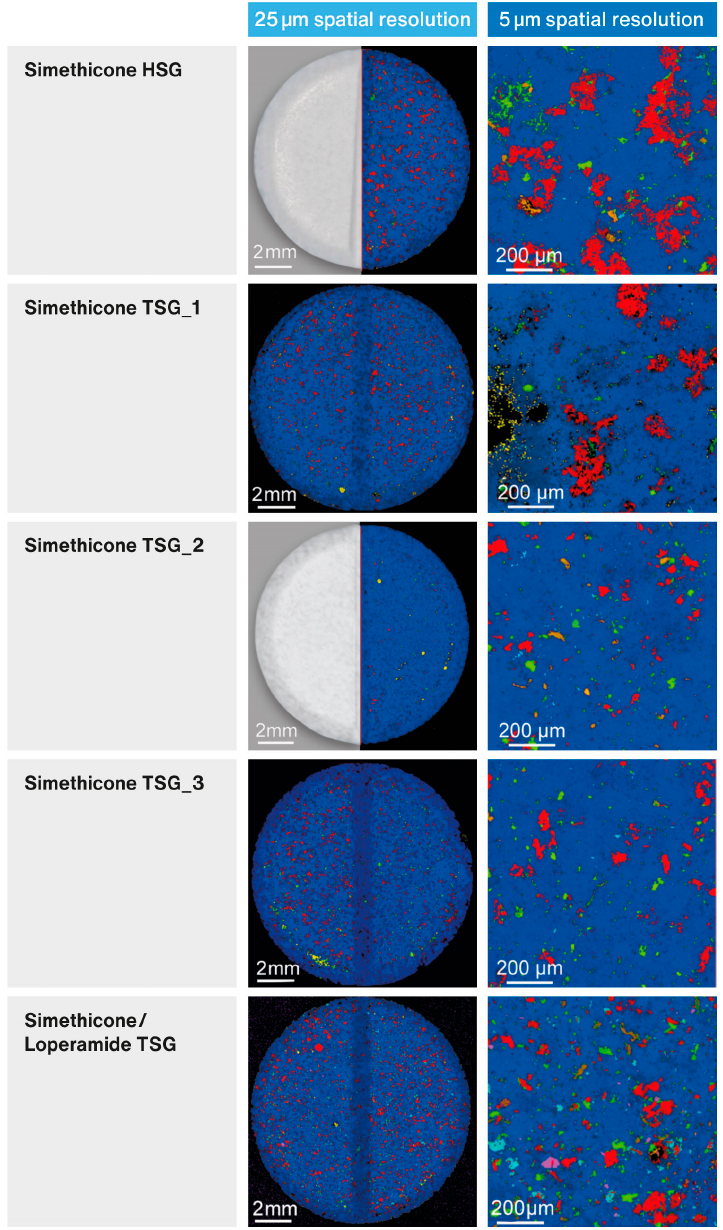
Figure 7. Raman maps of liquisolid tablets registered with 25 µm and 5 µm spatial resolutions. The spectra are separated into chemical components by MCR analysis and displayed in di ff erent colors.